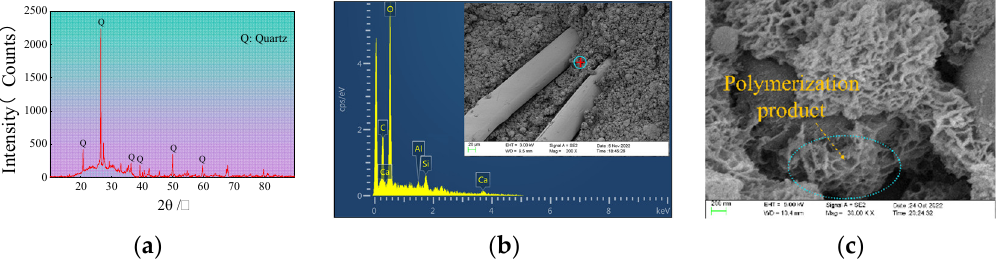
Figure 15. The X-ray spectrum, EDS energy spectrum and microstructure of the reaction products were analyzed. ( a ) X-ray spectrum analysis. ( b ) EDS energy spectrum. ( c ) Microstructure.